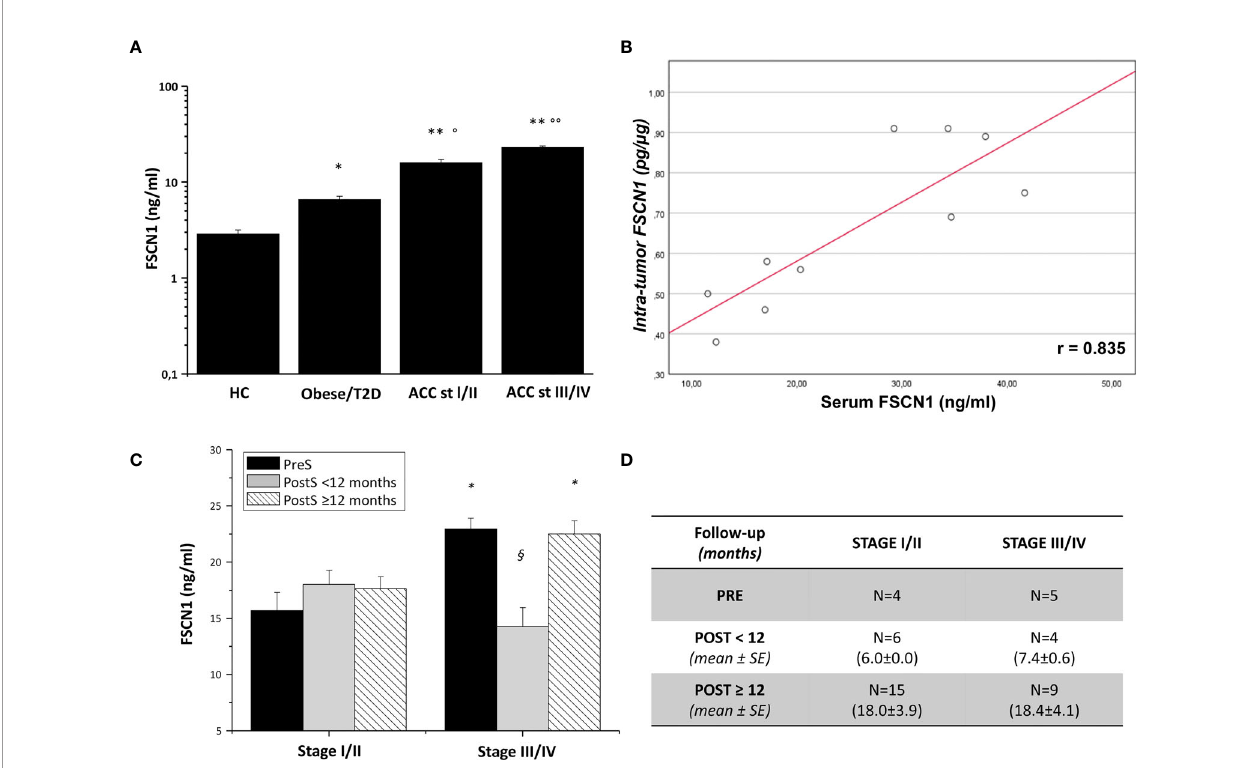
FIGURE 1 | FSCN1 detection in blood samples of ACC patients. (A) Quantitative evaluation of FSCN1 concentrations in pre-operative serum samples of ACC patients compared to obese/diabetic and healthy controls (HC). Data are expressed as mean ± SE of circulating FSCN1 levels measured in at least n=3 independent measurements. Statistical signi fi cance obtained by One-way ANOVA followed by Dunnett ’ s Post-hoc test: *P < 0.01, **P < 0.0001 vs HC, °P<0.01, °°P<0.001 vs Obese/T2D. (B) A statistically signi fi cant positive linear correlation was found between FSCN1 detected in serum samples and in tumor tissue samples, r=0.835, R 2 = 0.698, p=0.002, n=10. (C) Circulating FSCN1 levels were measured in patients with stage III/IV compared to stage I/II in pre-surgery (PreS) samples and after surgery at early (PostS <12 months) and long term (PostS ≥ 12 months) follow-up. Data are expressed as mean ± SE of protein levels in at least n= 3 independent measurements. Statistical signi fi cance obtained by One-way ANOVA followed by Dunnett ’ s Post-hoc: *P < 0.005 stage I/II vs III/IV; § P < 0.001 PreS vs PostS. (D) The table shows the number of patients with PreS, PostS<12, and PostS ≥ 12 samples and their follow-up time for post-surgery sampling (mean ± SE). In stage I/II group all patients had a R=0 resection status, while for stage III/IV group n=4 patients had R>0 in the PreS and PostS